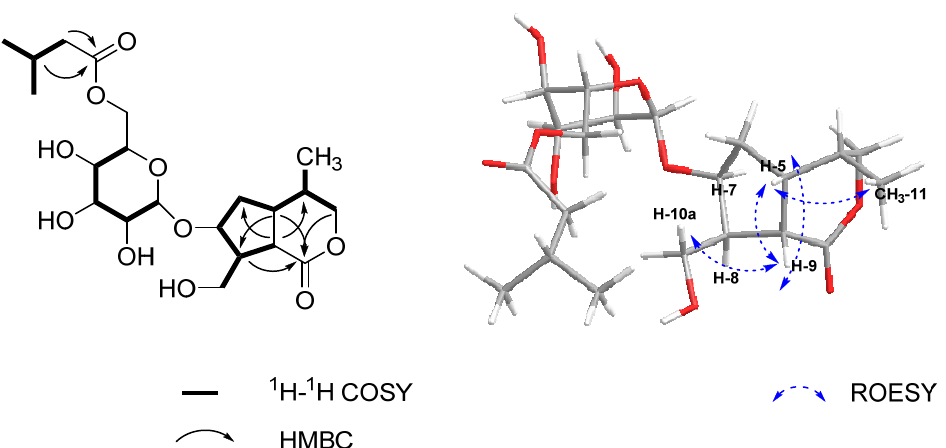
Figure 2. Key 1 H- 1 H COSY, HMBC, and ROESY correlations for compound 1 .